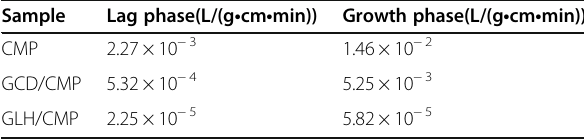
Table 1 Self-assembly rates of CMP, GCD/CMP and GLH/CMP